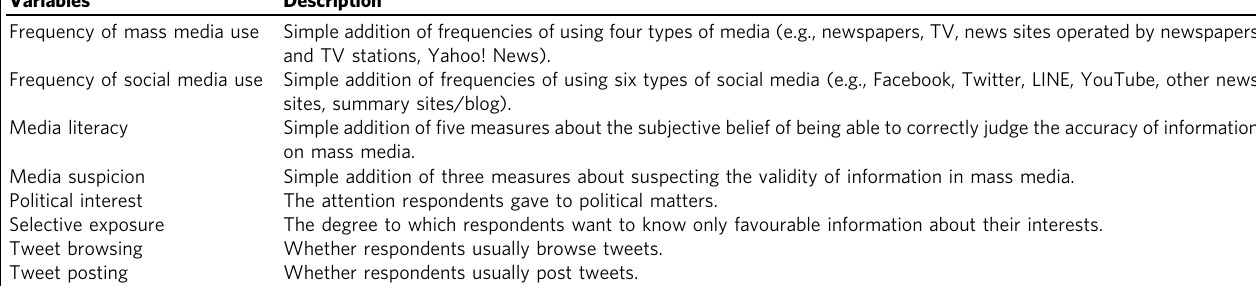
Table 2 Independent